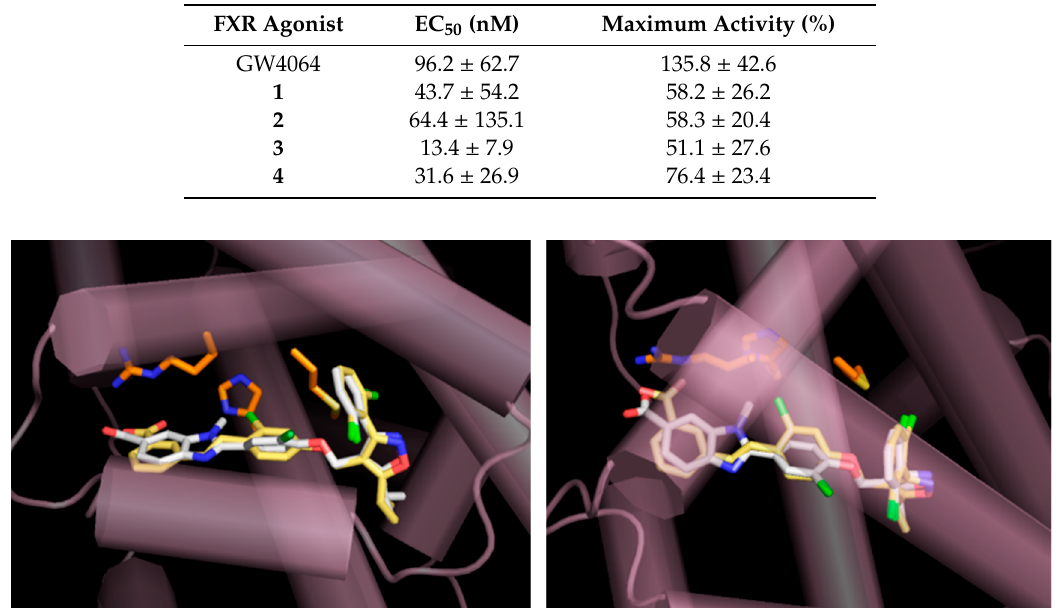
Table 1. Binding ability of FXR agonists by TR-FRET binding assay.